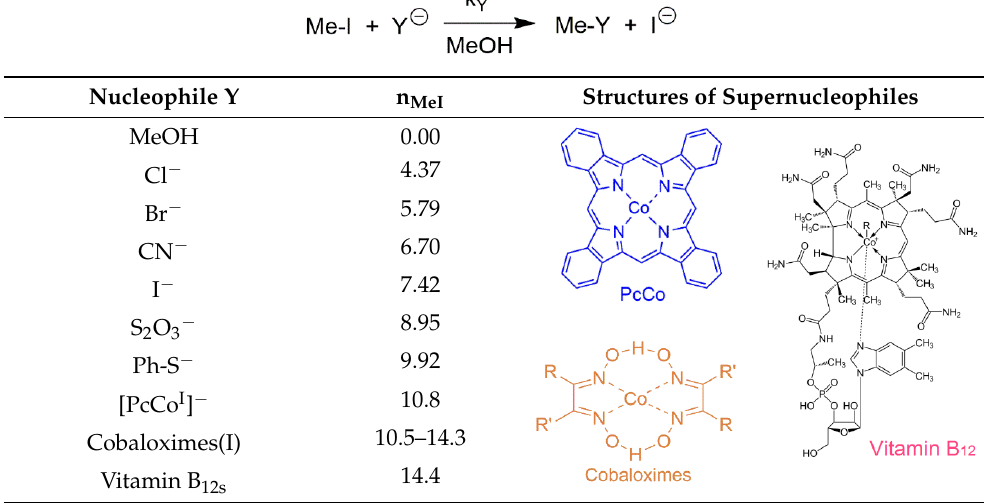
Nucleophile Y n